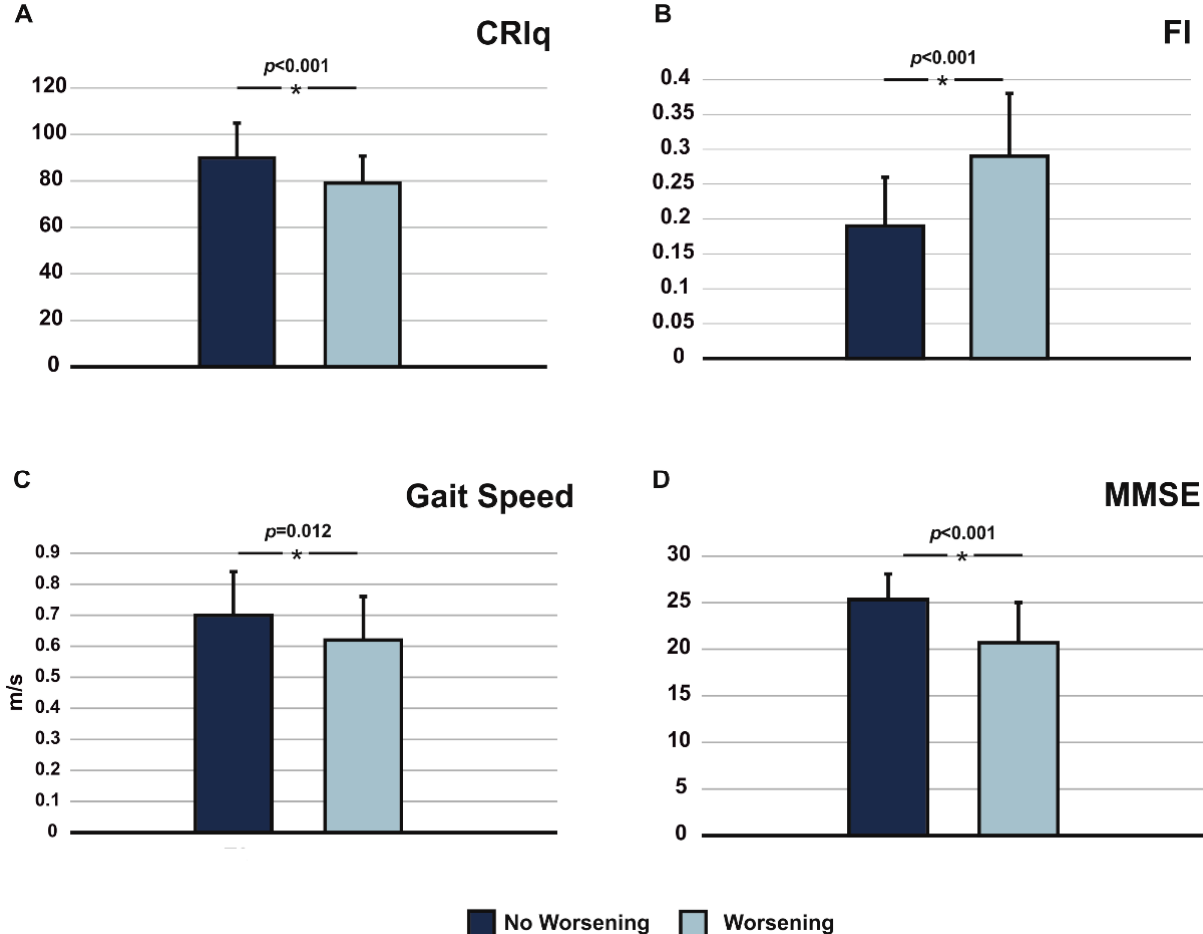
Figure 1. Comparisons of subjects with or without a cognitive worsening at one-year follow-up, based on baseline CRIq score (panel A ), Frailty Index (FI) (panel B ), gait speed (panel C ), and MMSE score (panel D ). Table 2. Associations of CR and premorbid IQ with functional